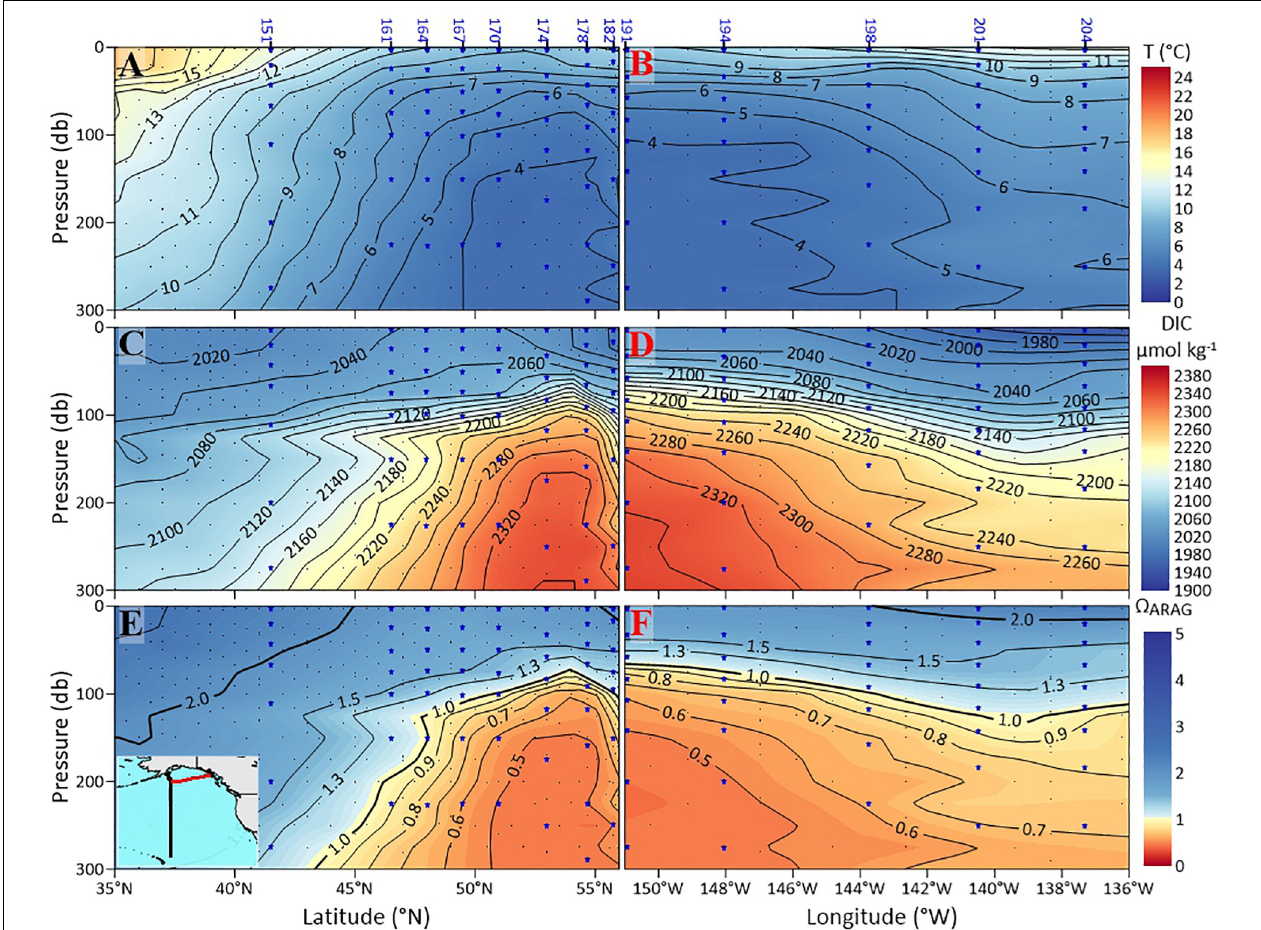
FIGURE 3 | Plots of observational data from the P16N cruise (Eastern Pacific subpolar gyre and the GoA) sections of: potential temperature ◦ C (A,B) ; dissolved inorganic carbon (DIC) in µ mol kg − 1 (C,D) ; and aragonite saturation state, (cid:127) ar (E,F) . The sections on the left are from the south to north transect (black-colored contour on the small map), and the sections on the right (red colored contour on the small map) are from the west to east transect (see insert map in E ). The pteropod station numbers are at the top. Indicated are the two solid black contour lines showing (cid:127) ar of 1 and